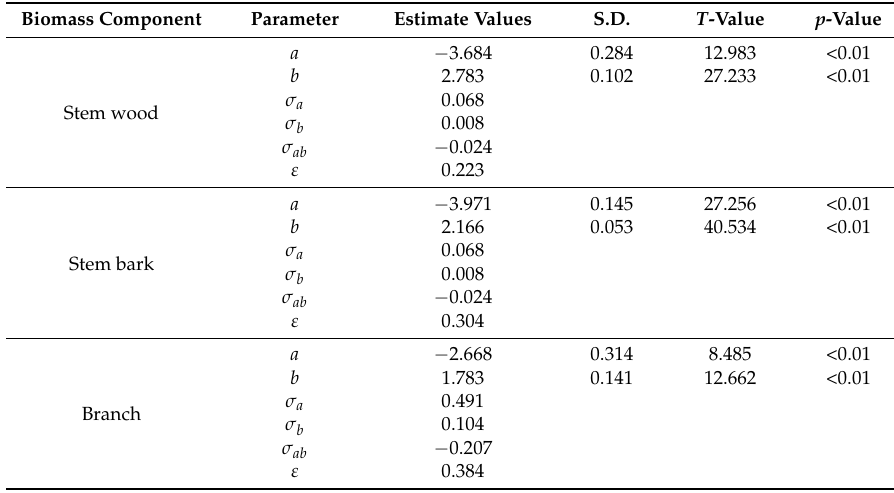
Table 5. Parameter estimates of the mixed effects model (Equation